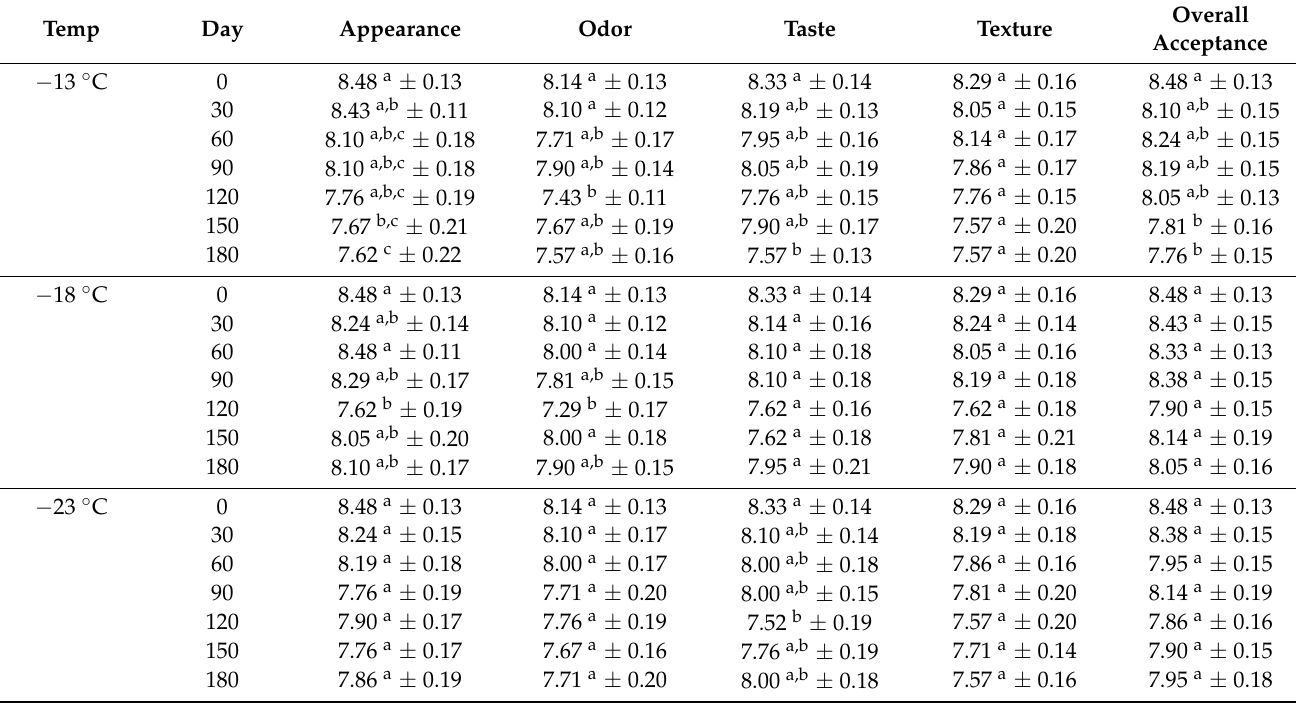
Table 8. Periodical values of sensory evaluation in processed chicken breast stored at different temperatures ( − 13 ◦ C, − 18 ◦ C, and − 23 ◦ C) for 180